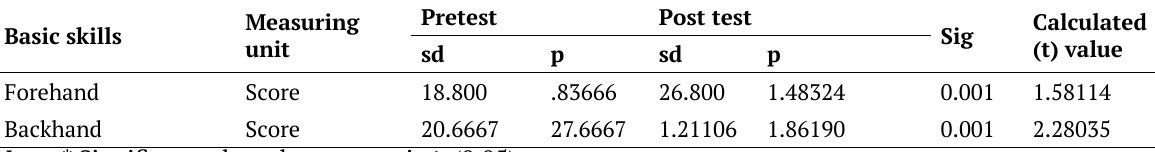
Table 2. The statistical differences in developing forehand and backhand tennis skills Basic